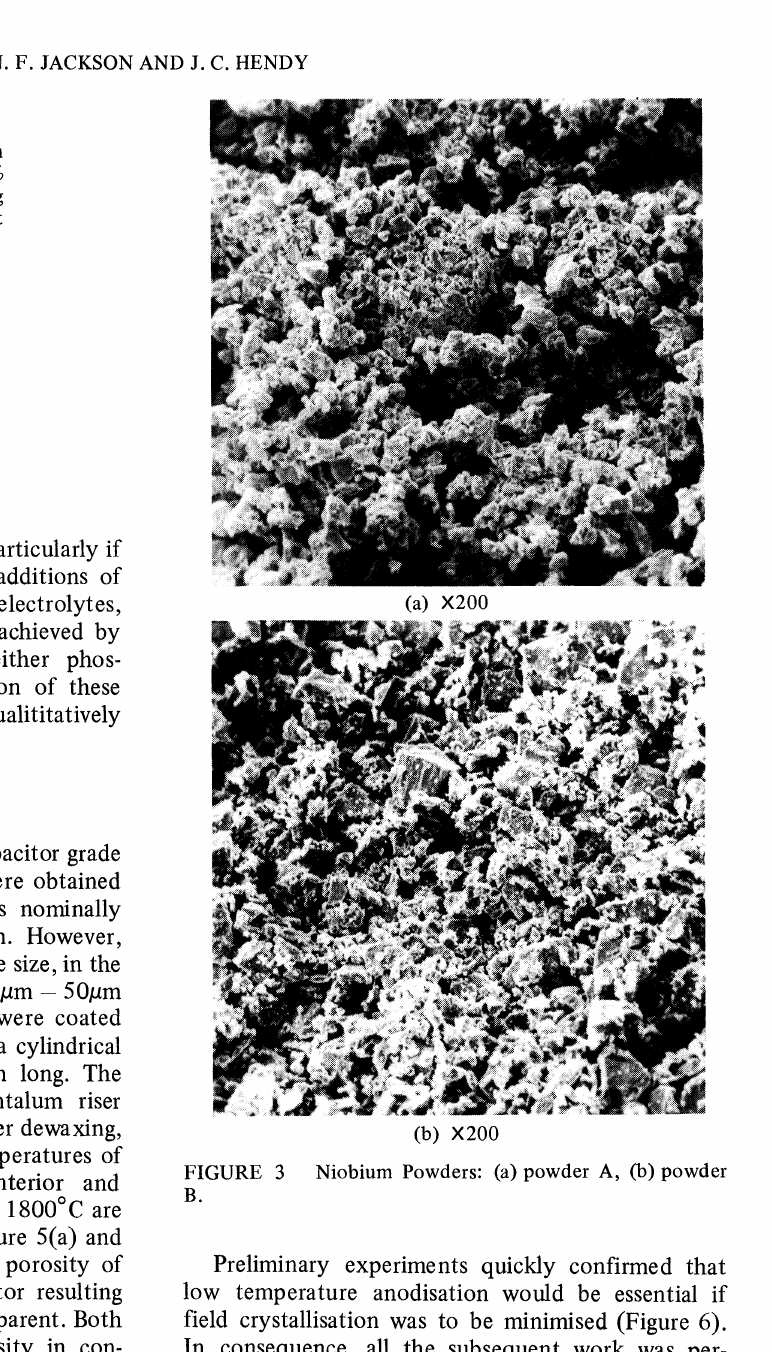
FIGURE 3 Niobium Powders: (a) powder A, (b) powder B. Preliminary experiments quickly confirmed that low temperature anodisation would be essential if field crystallisation was to be minimised (Figure 6). In consequence, all the subsequent work was per- formed in 1% phosphoric acid at 20C. For anodising voltages up to 110V, a current density of 50 mA per anode (’-0.05 mA cm -z) was applied to 75V at which voltage the current was reduced to 20 mA per anode. For voltages above 110V, 50 mA per anode was applied to a voltage 50V below the forming voltage and the anodisation was then completed